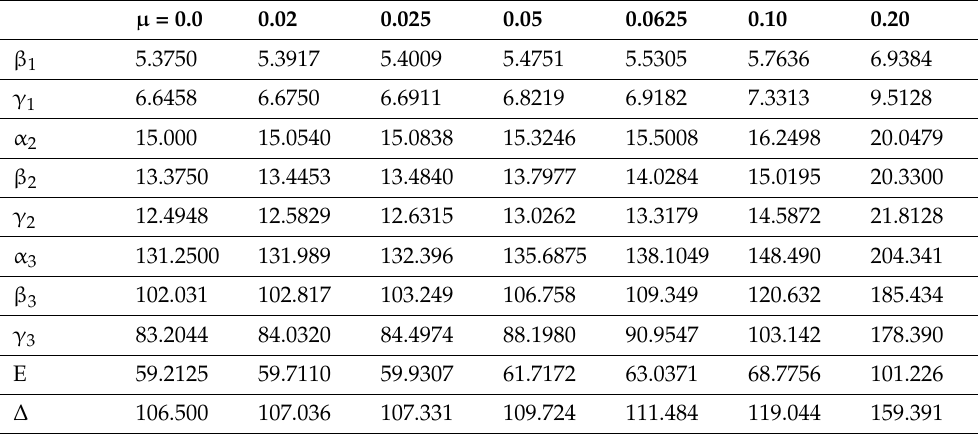
Table 2. Polarizabilities and hyperpolarizabilities for hydrogen atoms for various values of µ .